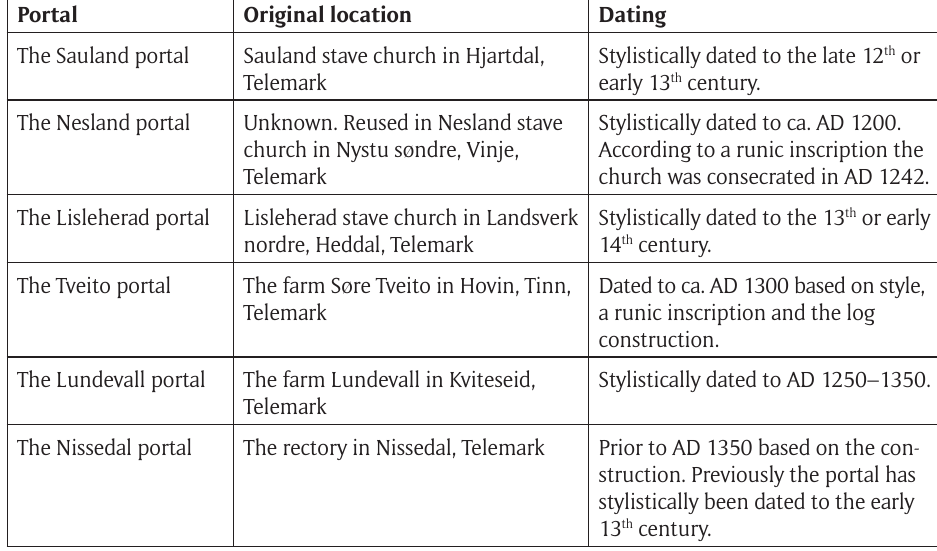
Table 1: The analysed